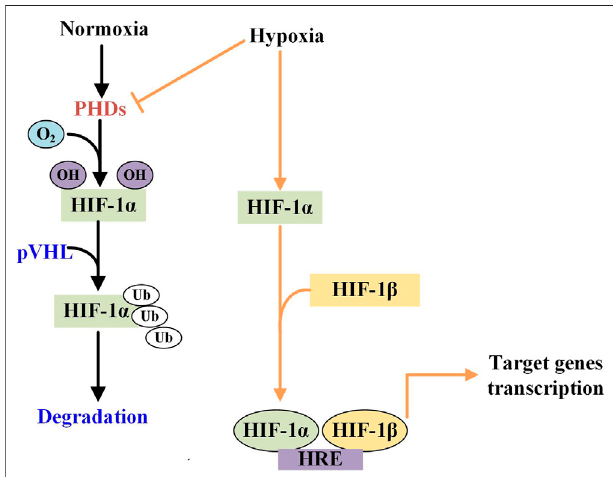
FIGURE 2 | The different effects of normoxia and hypoxiaon the HIF-1 α activity. Under normoxic condition, HIF-1 is hydroxylated by prolyl hydorylase (PHD) to attach with von HippelLindau (pVHL) protein and then is degraded. While in hypoxic condition, PHD is inhibited and HIF is phosphorylated which then is translocated and become dimerises with HIF-1 β in the nucleus. The heterodimer binds to the hypoxia response element (HRE) to activate the target genes